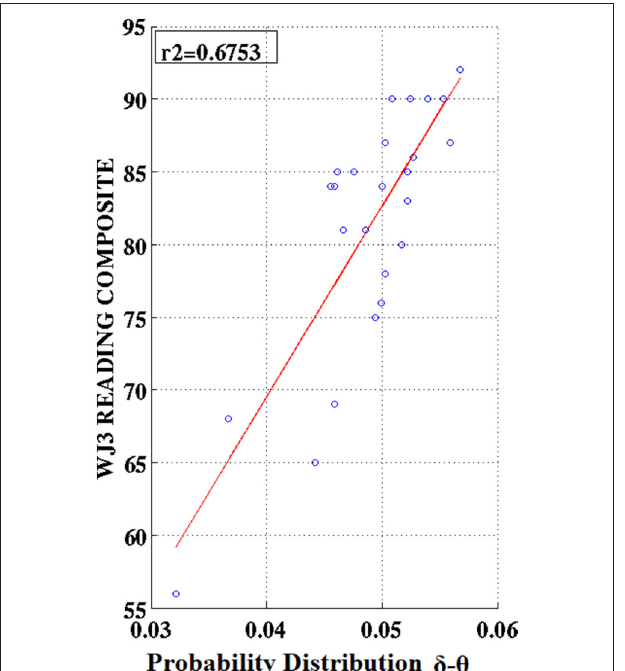
FIGURE 10 | Regression scatter plots of Woodcock–Johnson III (WJ3) Reading Composite scores over Probability Distribution values aggregated over right temporo-parietal sensors among RD participants.